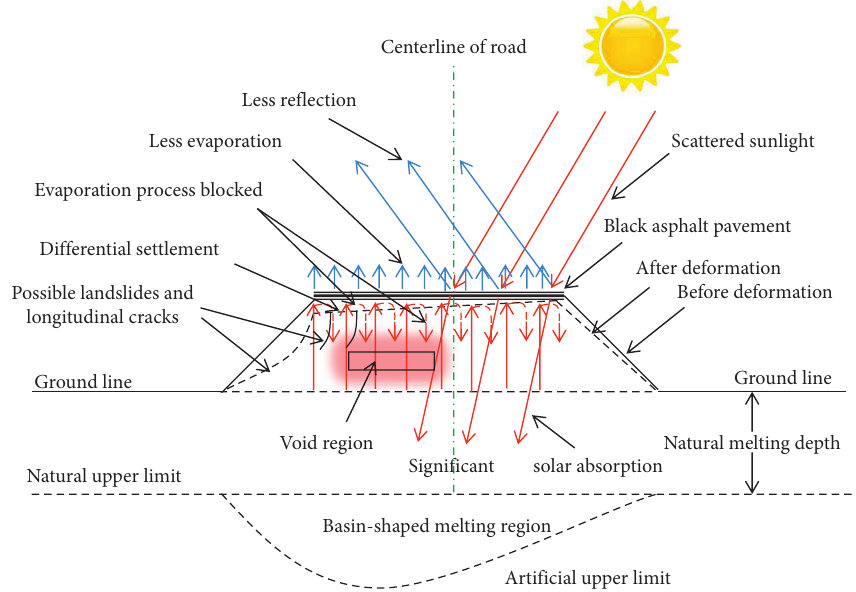
Figure 2: Mechanisms of the formation of uneven frozen soil subgrade settlement.